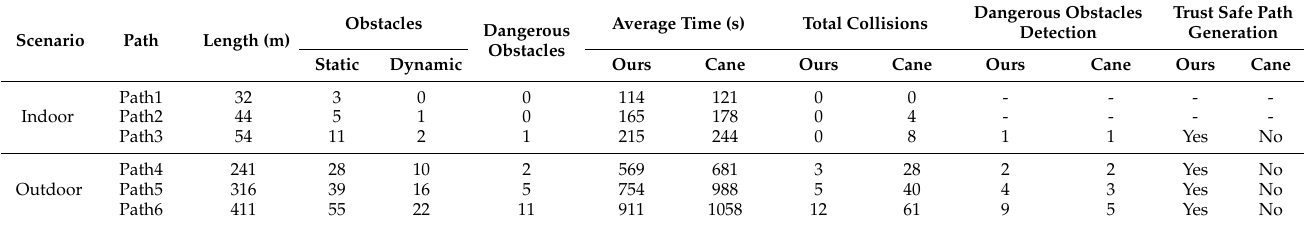
Table 3. Results of navigation assisted by a cane and with the designed system.